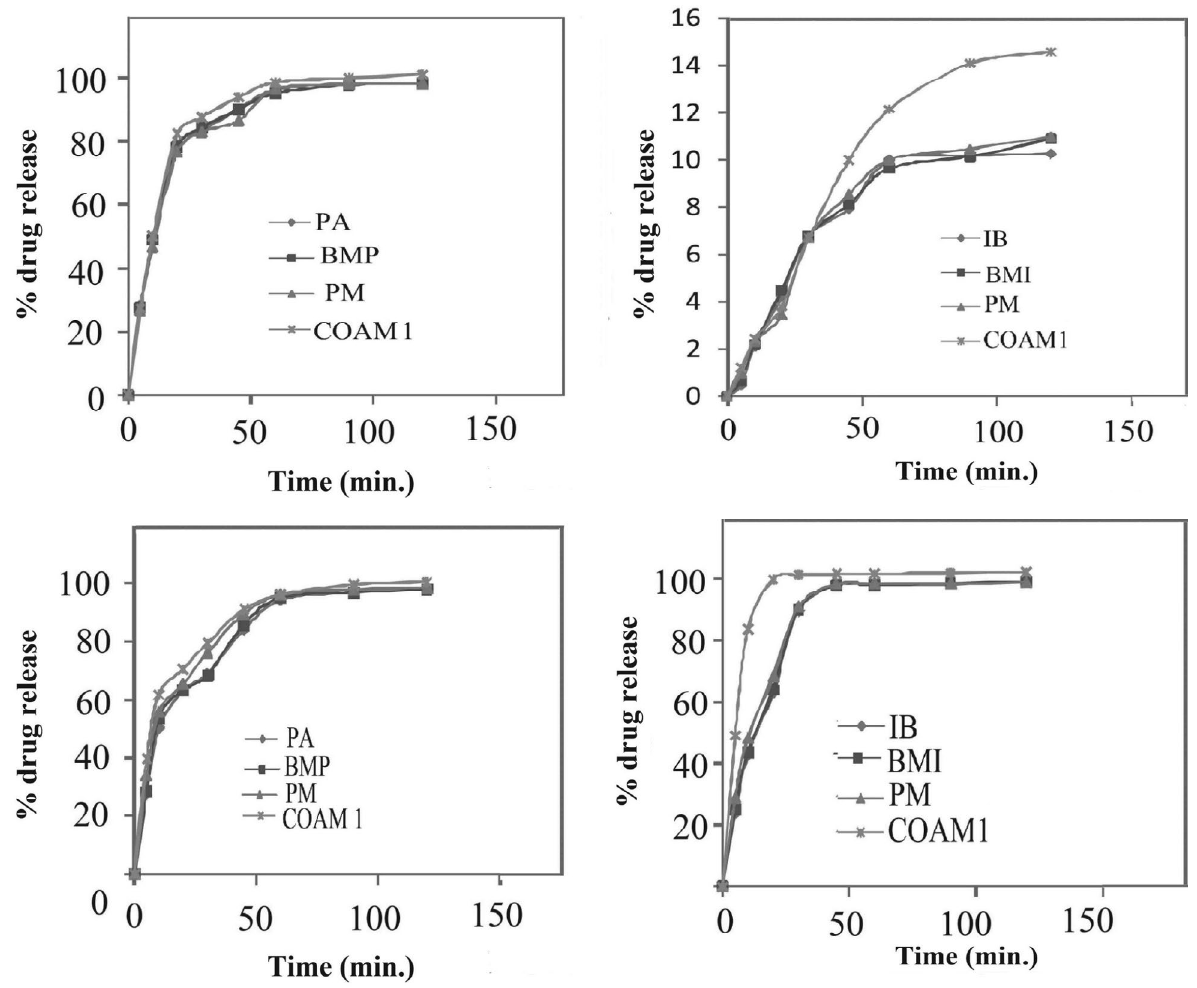
Figure 5. In-vitro dissolution profile of (a) PA in 0.1 N HCl, (b) IB in 0.1 N HCl, (c) PA in phosphate buffer (pH 7.2) and (d) IB in phosphate buffer (pH 7.2)